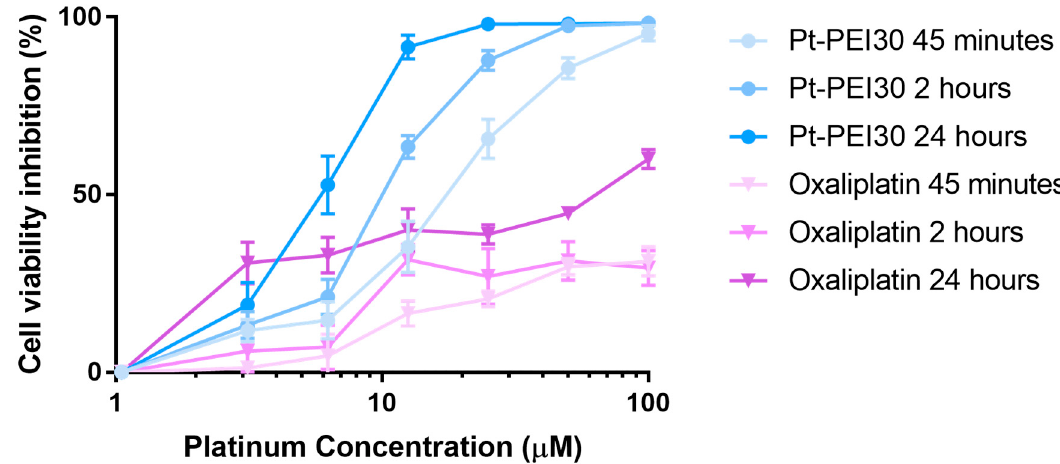
Figure 6. Effects on HCT116 cell metabolic activity of various exposure times of Pt-PEI30 conjugate and oxaliplatin as a reference. Results are expressed as mean ± SEM of at least four independent experiments. All concentrations (in µM) are expressed as platinum concentration.